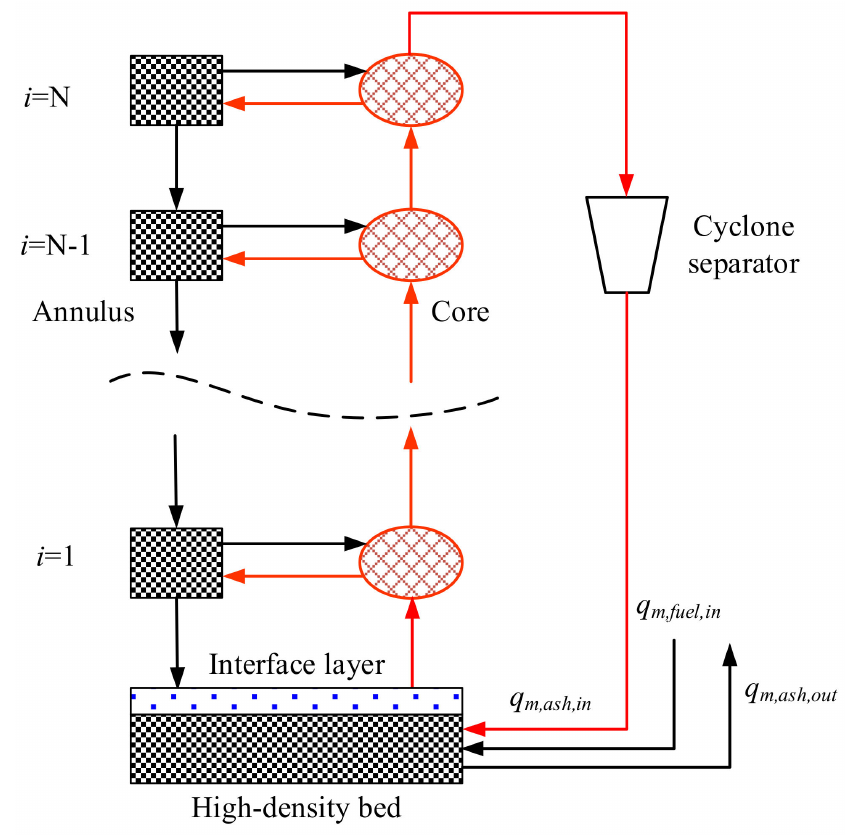
Figure 6. Diagram of “core-annulus” model in